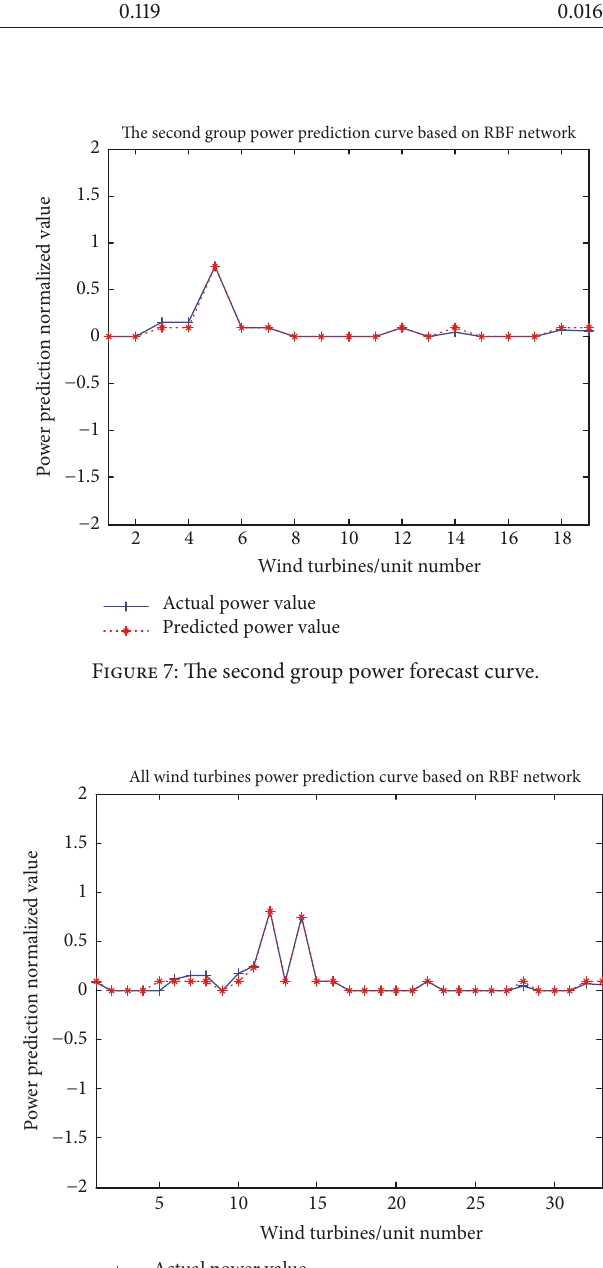
wind power forecasting can be effectively improved by the two-step ultra-short-time prediction